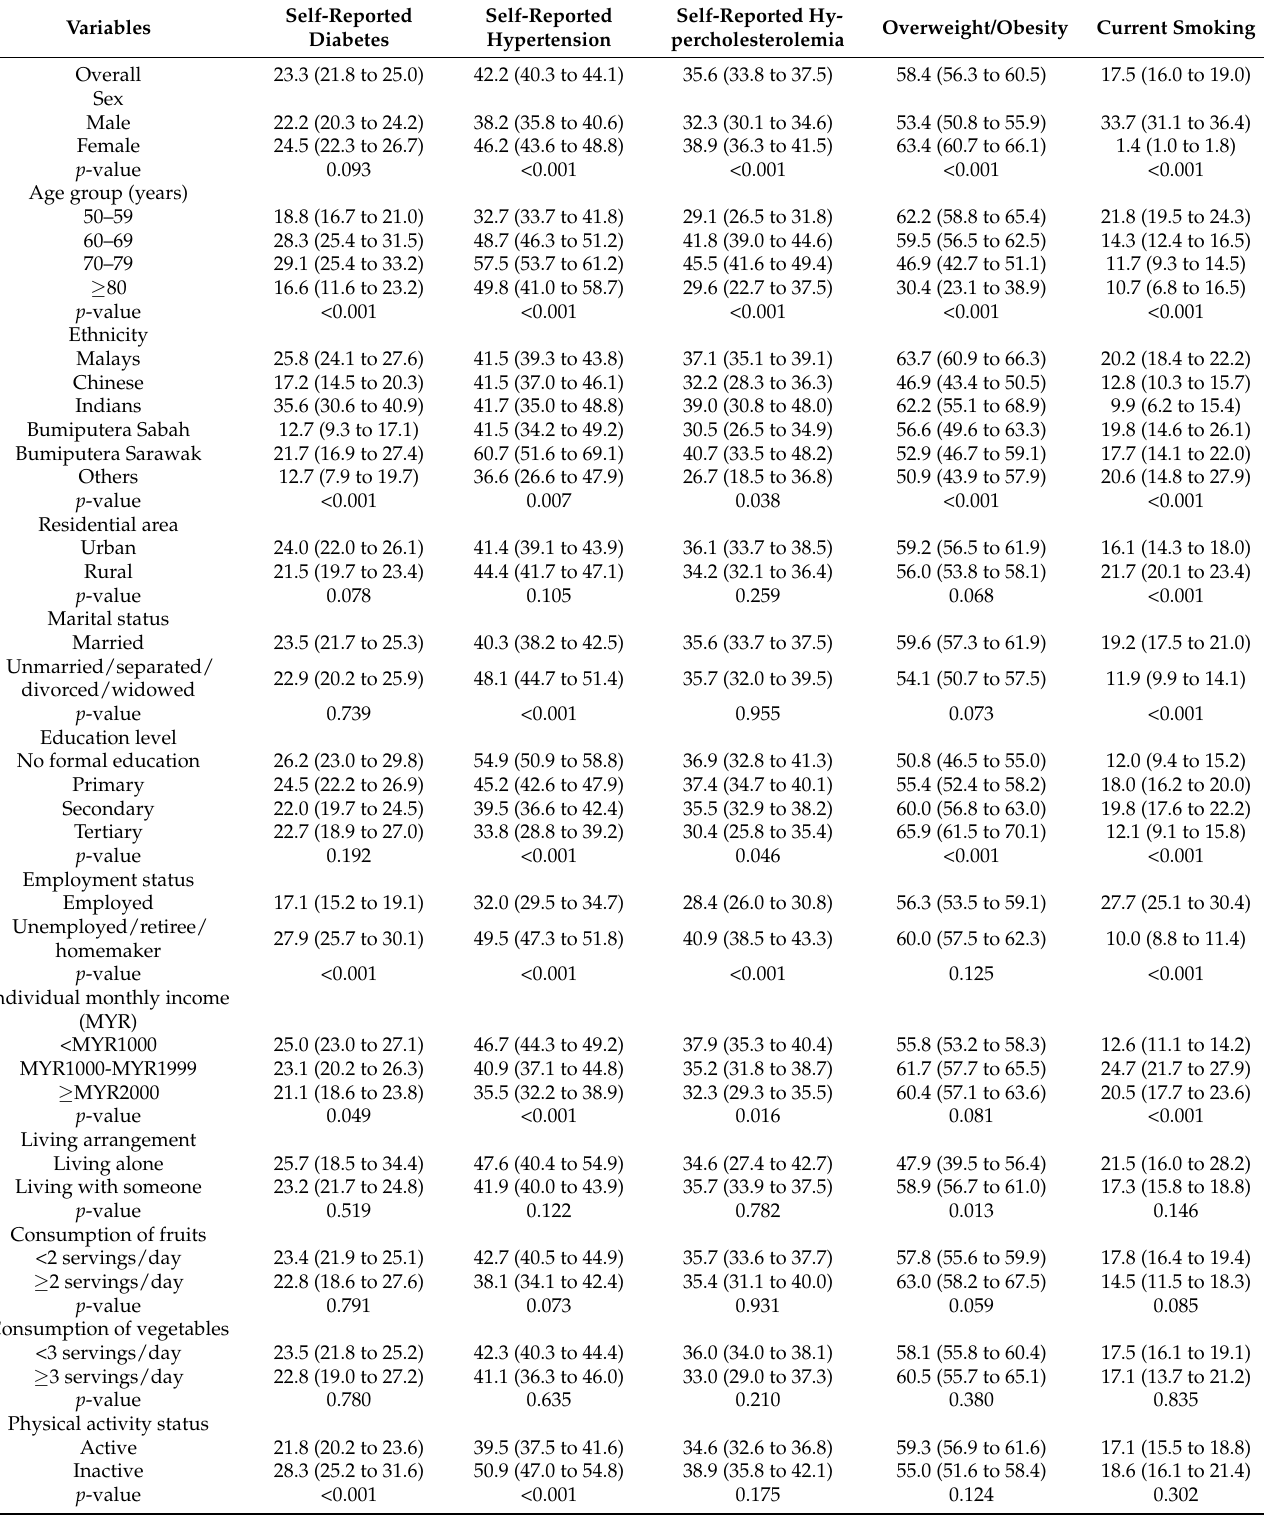
Table 2. The prevalence (95% CI) of modifiable risk factors of cardiovascular disease (self-reported diabetes, hypertension, hypercholesterolemia, overweight/obesity, and current smoking) by sociodemographic and lifestyle characteristics among older